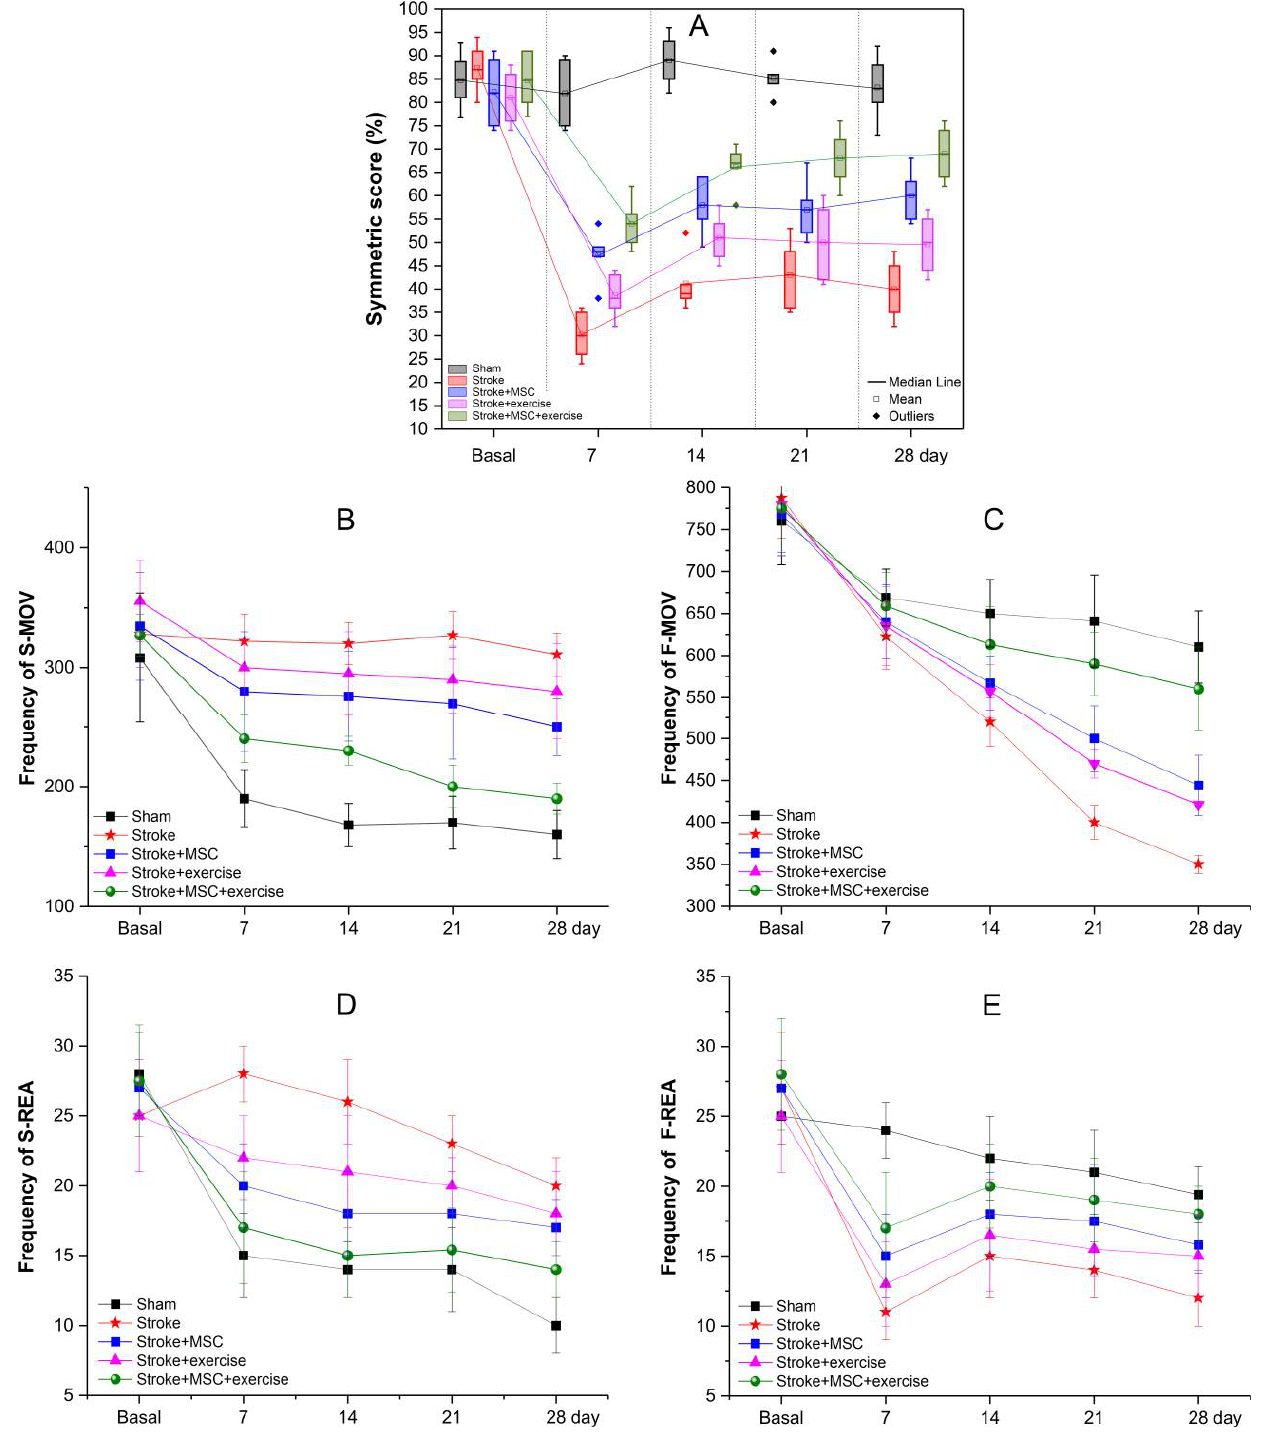
Figure 5. Behavioral evaluation by the cylinder test and the spontaneous locomotor activity test before stroke induction and at 7, 14, 21, and 28 days after in experimental groups (represented by the red star, blue square, pink triangle, and green circle) and control group (black square symbol). ( A ) over time by the cylinder test; ( B – E ) Motor evaluation by the spontaneous locomotor activity test considering the frequency of the following movements—( B ) Slow horizontal movements (S-MOV); ( C ) Fast horizontal movements (F-MOV); ( D ) Slow vertical movements (S-REA); and ( E ) Fast vertical movements (F-REA).